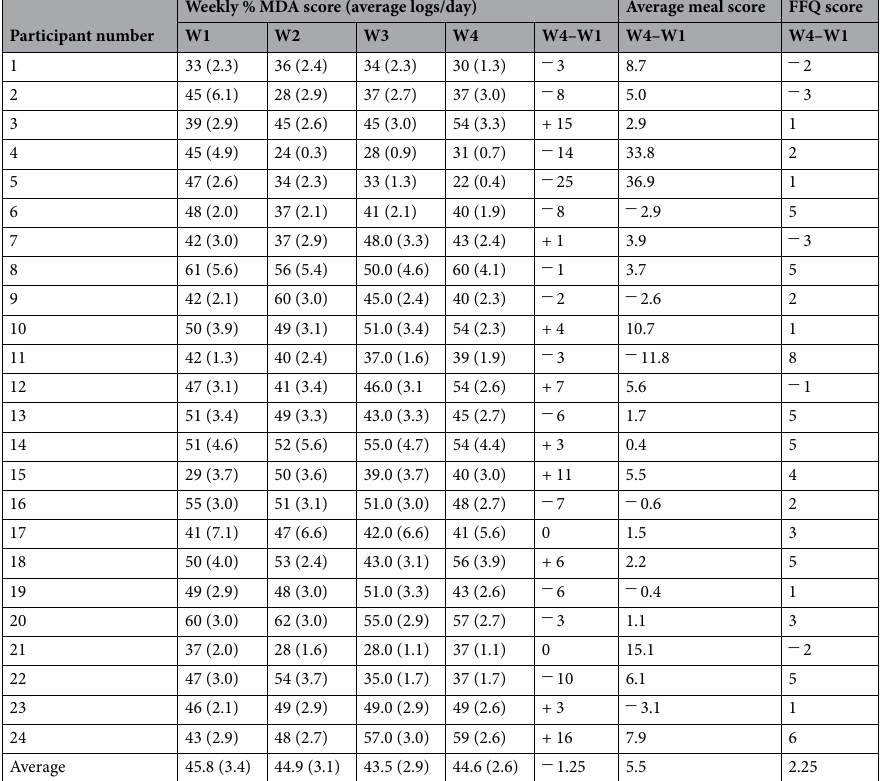
Table 4. % MDA scores per participant for each week (Wi, i = 1,. . ., 4), as calculated by the system and the FFQ. The average number of images logged per day, for every week is shown in parentheses for W1–W4. The weekly % MDA score (W4–W1) and the average meal score (W4–W1) columns show the difference between the last and the first week for the MDA score and the average meal score respectively. The final column shows the difference between the final and initial FFQ